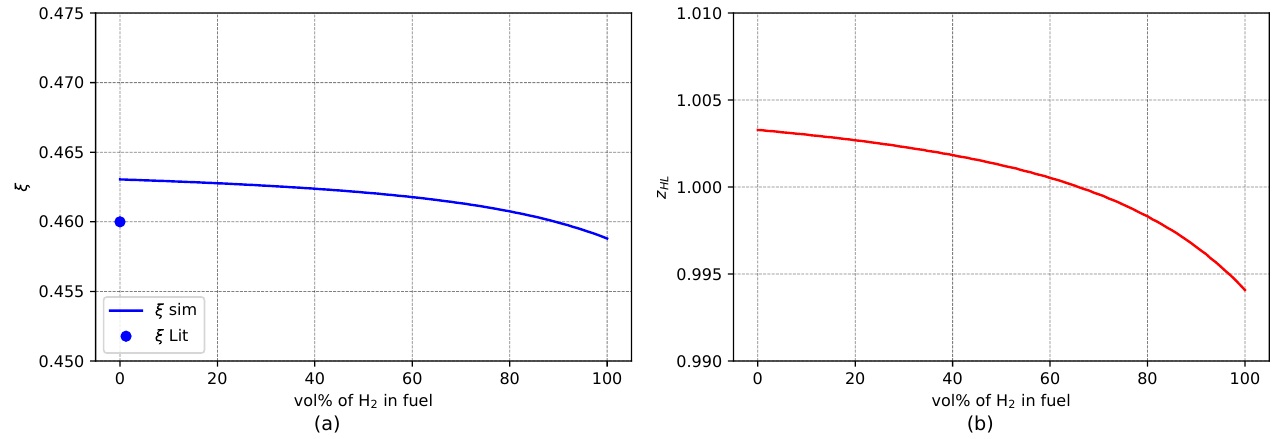
Figure 10. ( a ) Temperature efficiency ξ with increasing H 2 shares in fuel, compared to a literature value for oxyfuel combustion given in Ref. [15]. ( b ) Heat capacity flow ratio z HL with increasing vol% of H 2 in fuel for a normalized pull of φ = 1.0. Ideal values are reached for z HL → 1.00. Literature values of z HL for oxyfuel fired furnaces range between 0.85 and 1.15 [15].